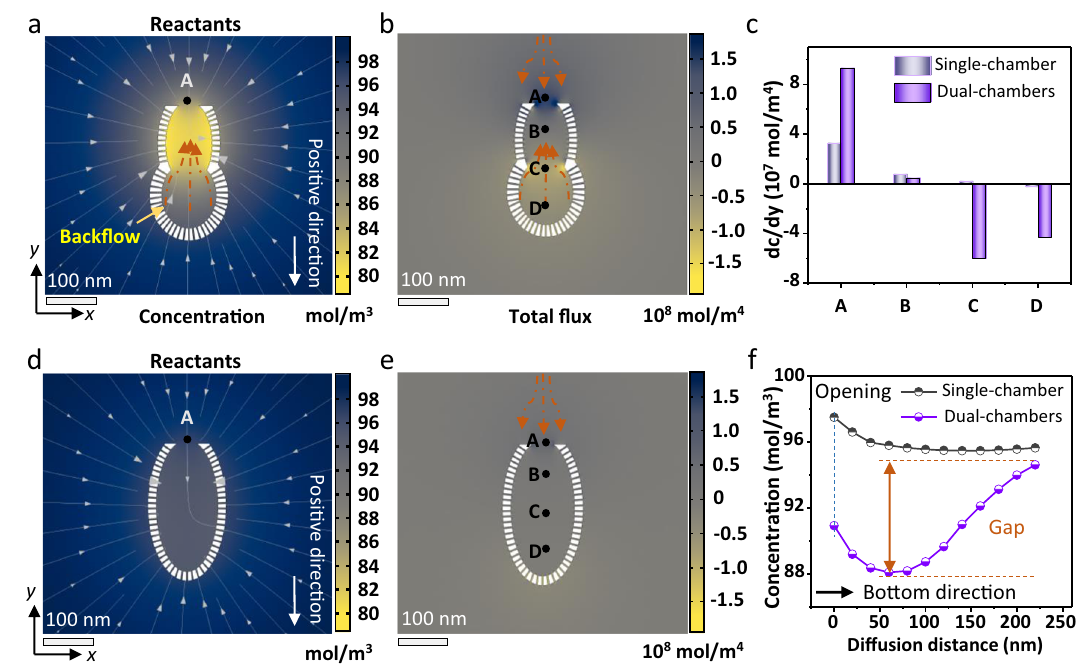
Fig. 6 | Finite element analyses of the mass transfer in the nanoreactors with differentmorphologies.a , d Thesimulatedtransient-stateconcentrationgradient ofthereactantsindifferentnanoreactorsat20 µ s. b , e Thecorrespondingtotal fl ux pro fi les of reactants in single- and dual-chambered nanoreactors at 20 µ s. Position A is the opening of the nanoreactor, Position B is the center location of the upper chamber, Position C is the middle of the whole cavity, and Position D is the center location of the bottom chamber. c The calculated transient-state concentration